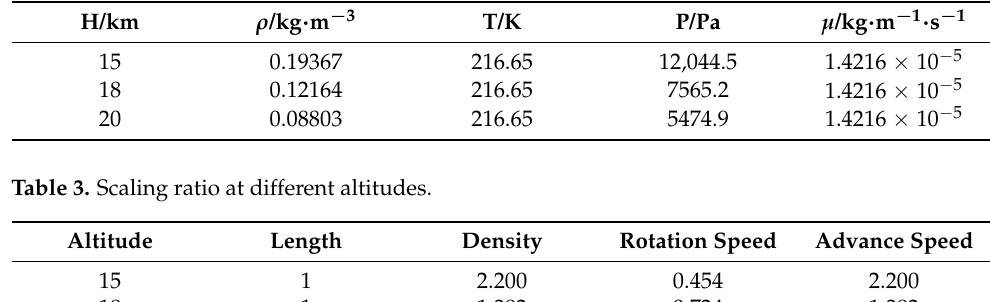
Table 2. Atmosphere conditions at different altitudes.